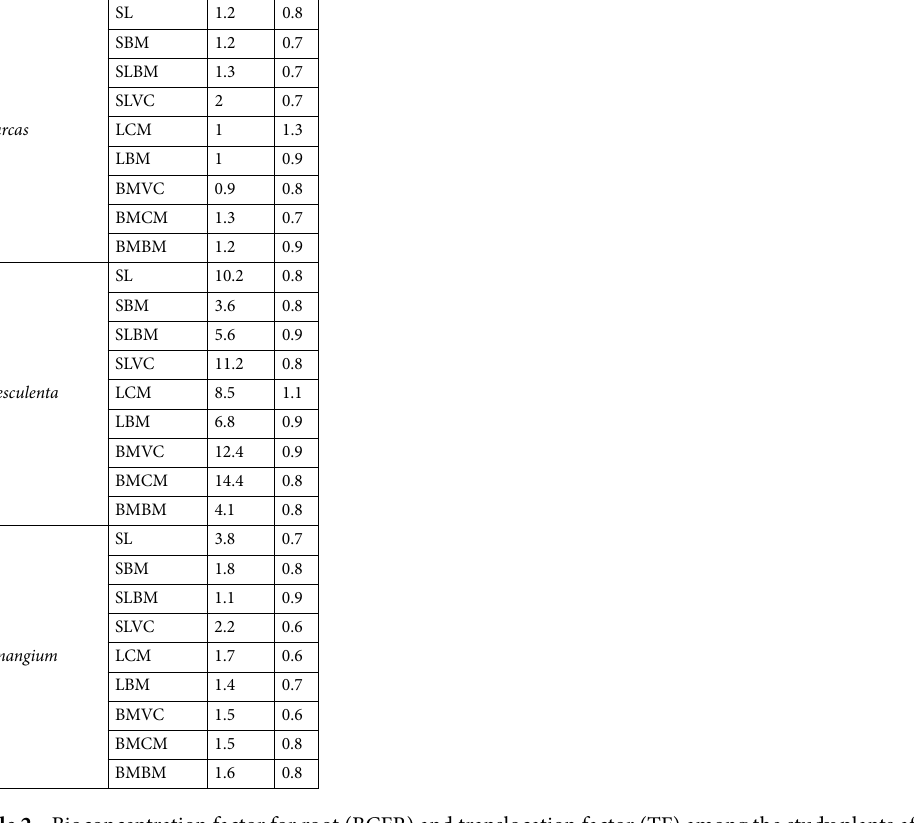
Table 2. Bioconcentration factor for root (BCFR) and translocation factor (TF) among the study plants after harvest ( n =